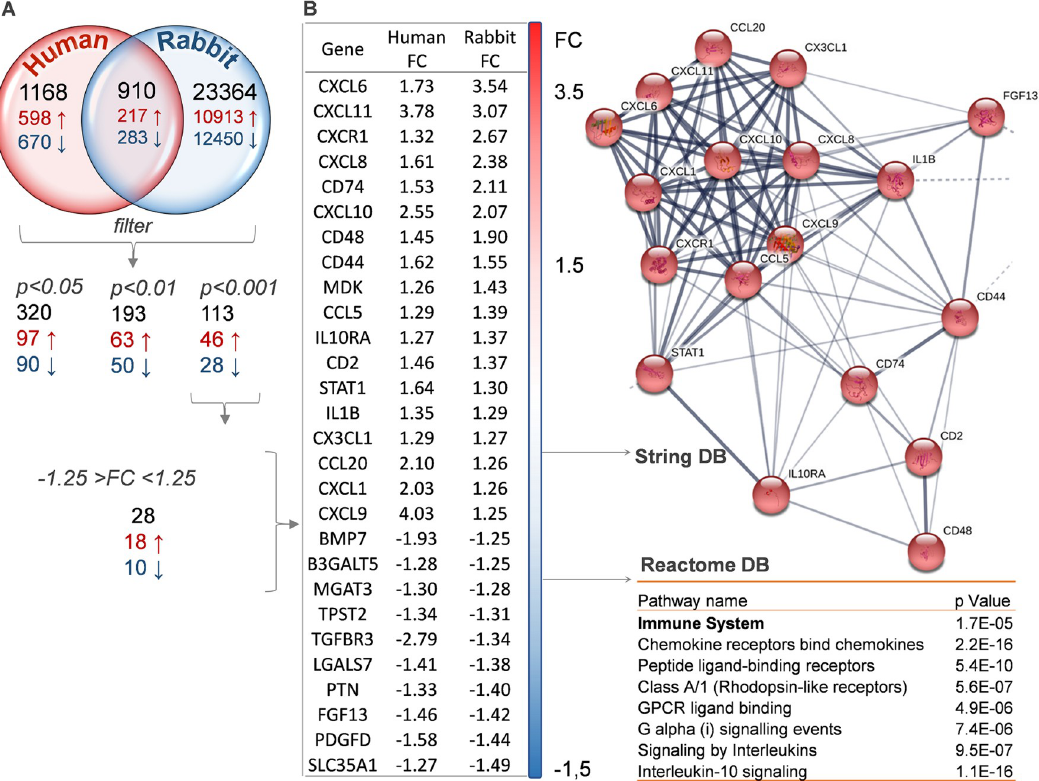
Fig 8. Gene expression in patients with DED not related to Sjogren syndrome. A . Venn Diagram depicts the overlap between rabbit and human non-Sjogren’s DED microarray data. Of the 910 overlapping and annotated genes, 217 were similarly upregulated and 283 downregulated in both species, the remaining 410 were changed in opposite directions. The distribution of these genes based on the threshold of statistical significance (TAC, as in Methods) is also shown. B . 28 genes were subtracted from the p < 0.001 group, based on their FC values and listed in descending order according to the FC in rabbit gene expression. The String database (DB) revealed a cluster among them related to the immune response (upper part), whereas the Reactome DB system identified several pathways, with the top one being the immune system, common to human and rabbit